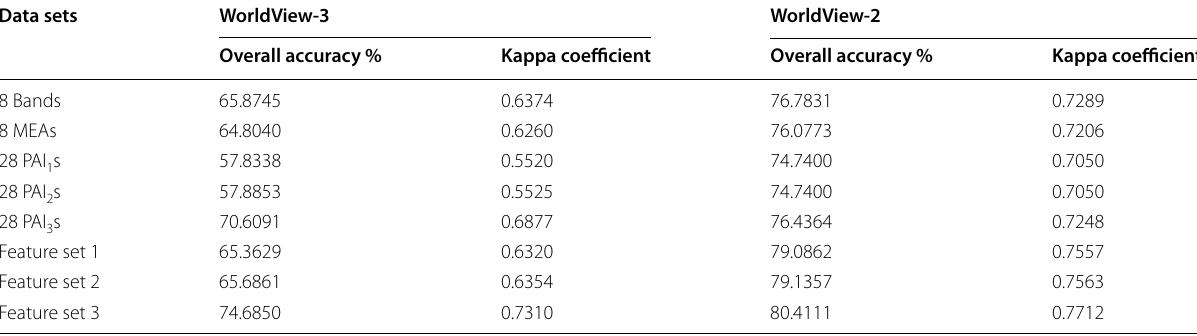
Table 5 Overall accuracy and kappa coefficient of tree species identification based on different feature sets Data sets